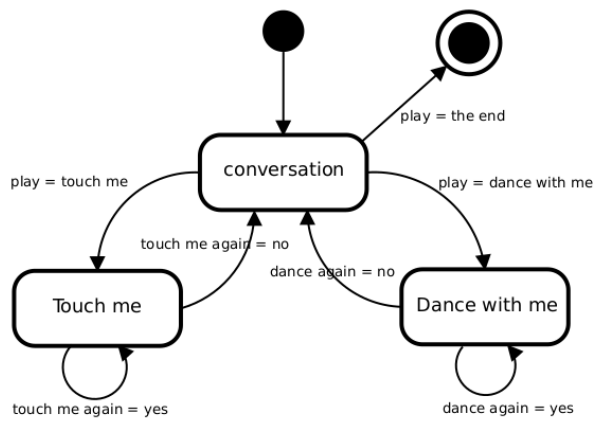
Figure 1. Interactive game scenario in terms of a finite-state